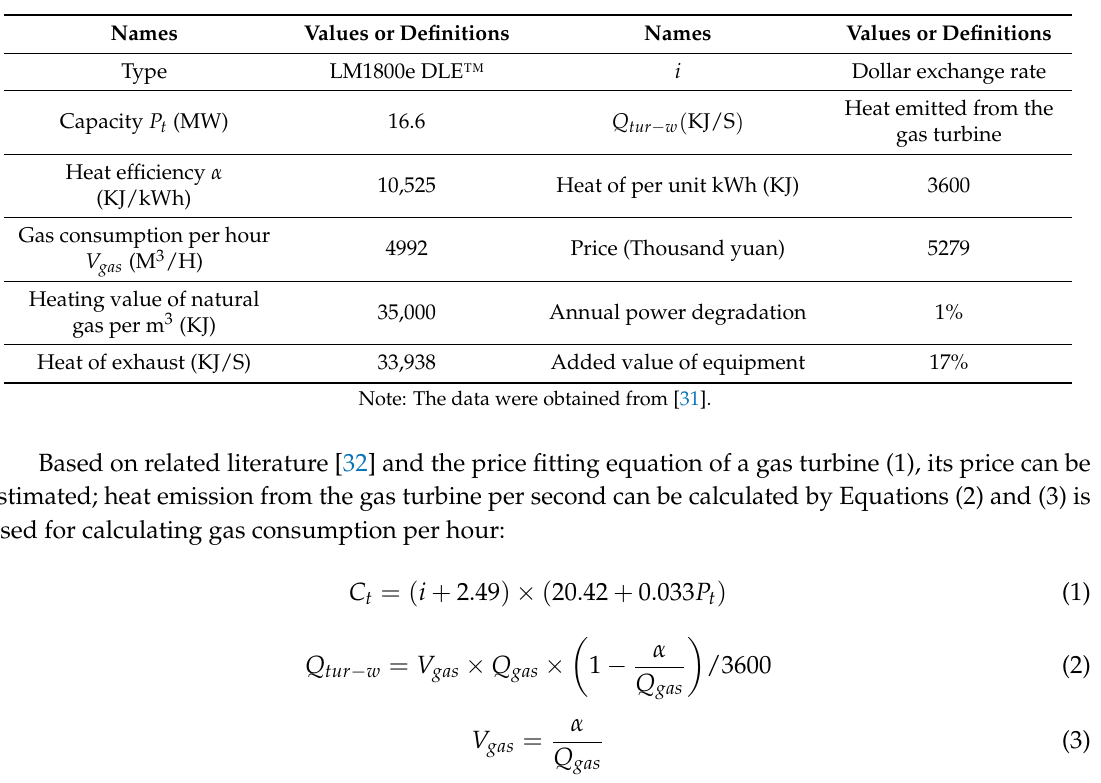
Table 1. Parameters of the gas turbine.